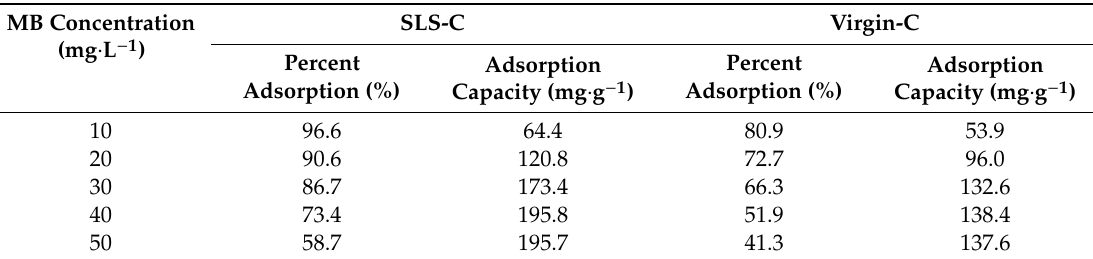
Table 1. E ff ect of initial MB concentration on the percentage extraction of